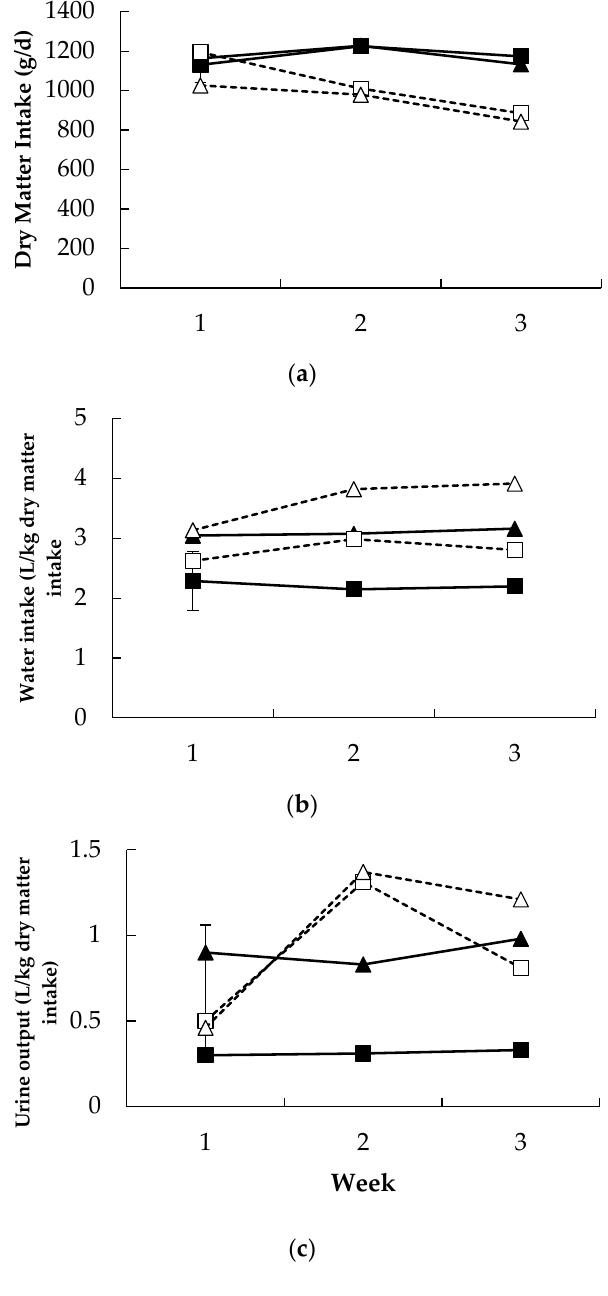
Figure 2. Relationships between ( a ) dry matter intake, ( b ) water intake, and ( c ) urine output and week of study in Merino sheep fed diets containing no ( ■ , ▲ ) or added perennial ryegrass alkaloids ( □ , Δ) under either thermoneutral (squares) or heat (triangles) conditions. The p -values for the effect of alkaloid, temperature, week and the interaction between week and temperature, week and alkaloid and week, alkaloid and temperature were 0.008, 0.53, <0.001, 0.35, <0.001 and 0.02 for dry matter intake, 0.09, 0.02, 0.02, 0.17, 0.008, 0.68 for water intake and 0.25, 0.39, 0.09, 0.65, 0.04 and 0.87 for urine output, respectively. The standard error of the difference for the three-way interaction is displayed on the data from the sheep receiving no alkaloids under thermoneutral conditions. There were no other significant interactions.